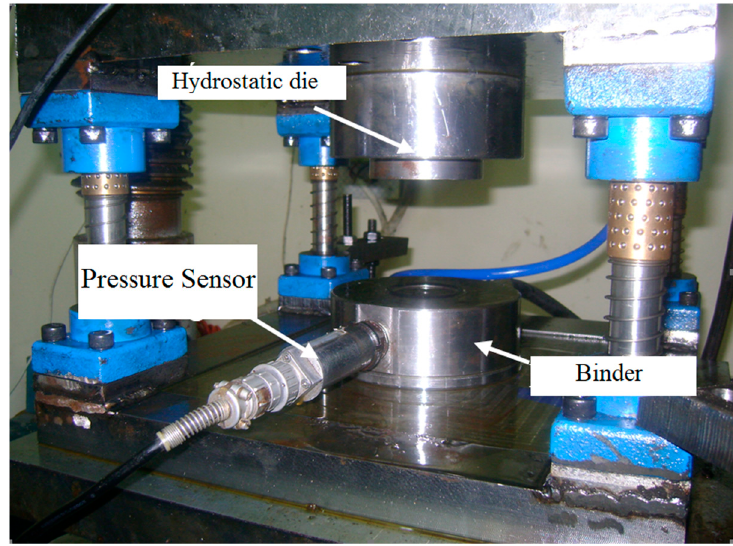
Figure 6. Experimental system.